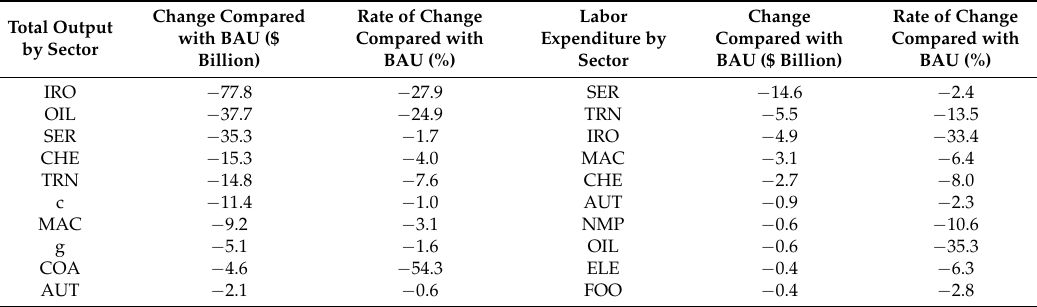
Table 11. POL_30 scenario ripple effect by